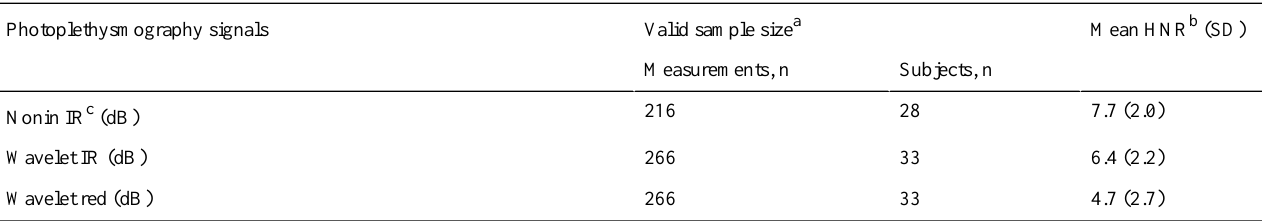
Table 2. The mean and SD of the average harmonic-to-noise ratio for the photoplethysmography recordings collected from the Wavelet wristband and reference Nonin finger-clip pulse oximeter.